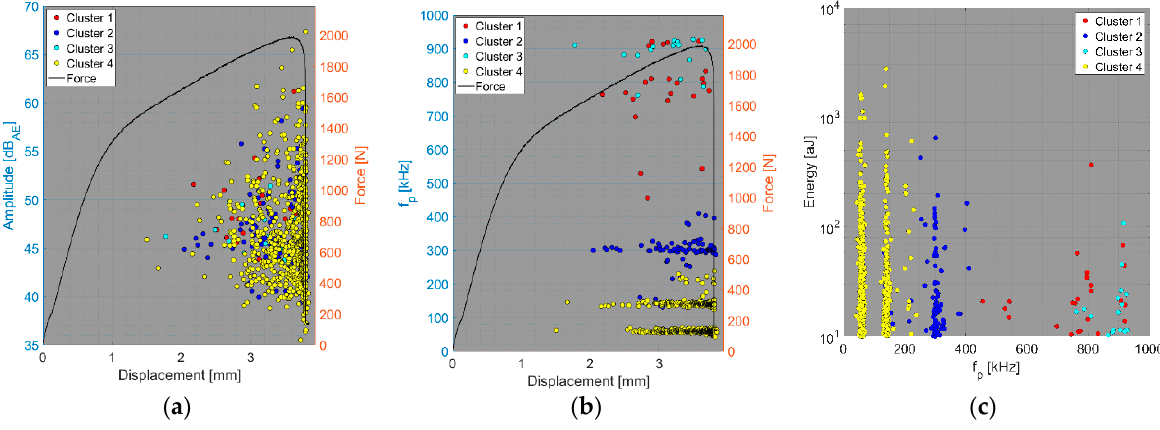
Figure 21. Clustering results for a CPT representative sample using a spectral clustering algorithm (DWC 454 dataset).